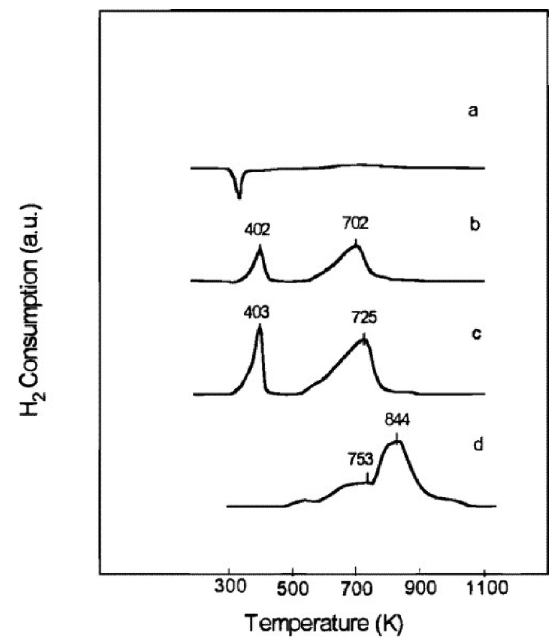
Fig. 2 – Reduction profiles of the niobia-supported catalysts. (a) Pd/ Nb 2 O 5 ; (b) Pd 35 Co 65 /Nb 2 O 5 ; (c) Pd 15 Co 85 /Nb 2 O 5 ; (d) Co/Nb 2 O 5 (Noronha et al.